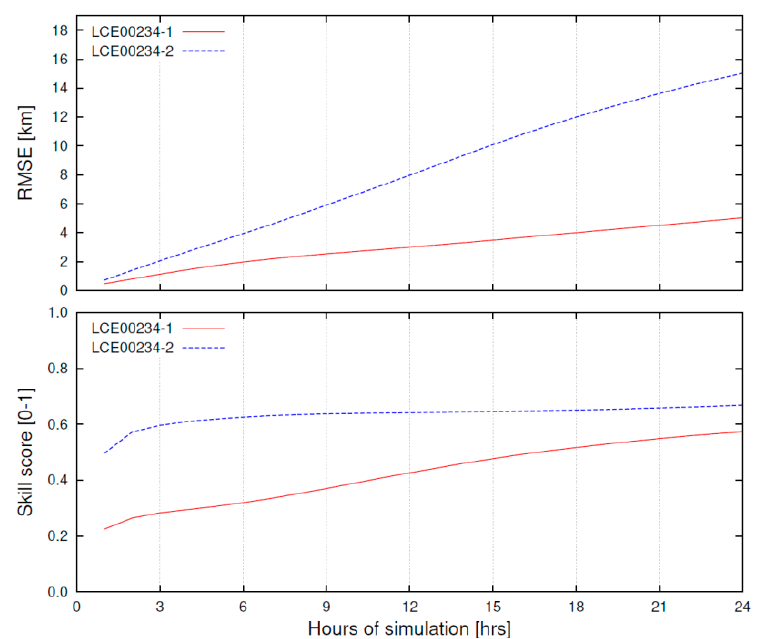
Figure 6. Observed (black thick line) and mean simulated (yellow lines) trajectories for the drifters LCE00234-1 with a drogue at 20 m ( a ), and LCE00234-2 with a drogue at 1 m ( b ), below the sea surface. The green thick line represents the mean trajectory of the particles released at the beginning of simulations. The circles mark the oil platforms.